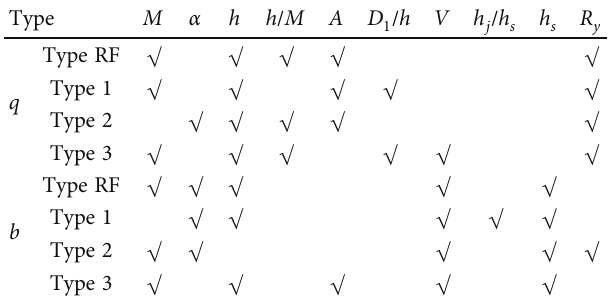
Table 6: RF feature selection for input layer